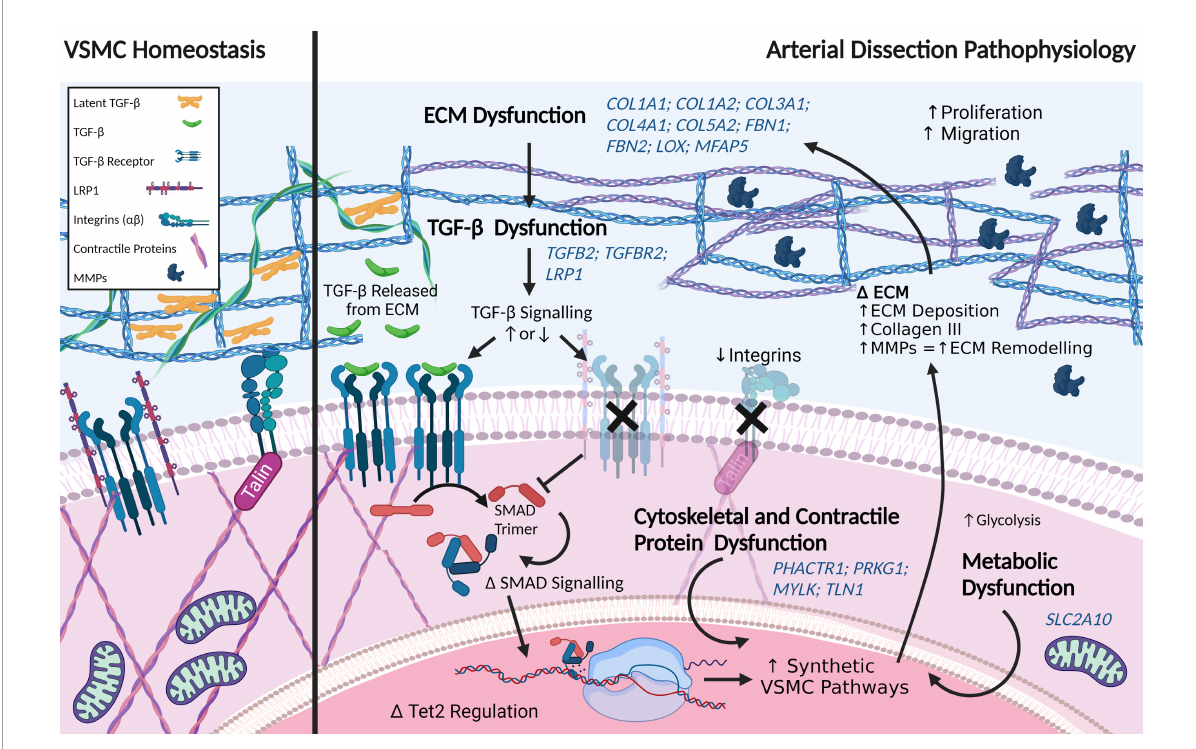
FIGURE6 Pathways perturbed in arterial dissections include the extracellular matrix (ECM), TGF- β , signaling, cellular contraction/cytoskeleton, and metabolism. Dysregulation in any number of these pathways can drive vascular smooth muscle cells (VSMCs) toward a more synthetic phenotype. Variants in the same genes (italicized in blue) belonging to these pathways have been commonly identified in at least two types of arterial dissections. Created with